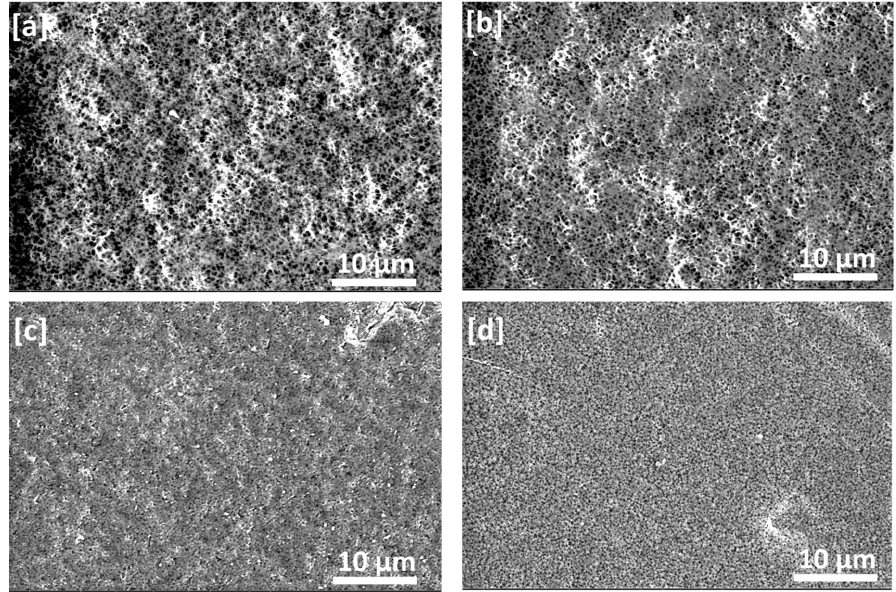
Figure 3. SEM micrographs of PVDF flat-sheet membranes fabricated by the phase inversion method from the DMF/acetone solutions with different compositions of solvent mixtures: ( a ) Con- trol membrane DMF/acetone: 100/0, ( b ) DMF/acetone: 80/20, ( c ). DMF/acetone: 60/40 and ( d ) DMF/acetone: 50/50.